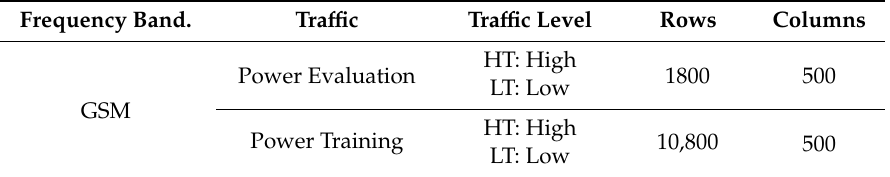
Table 2. Selected data.